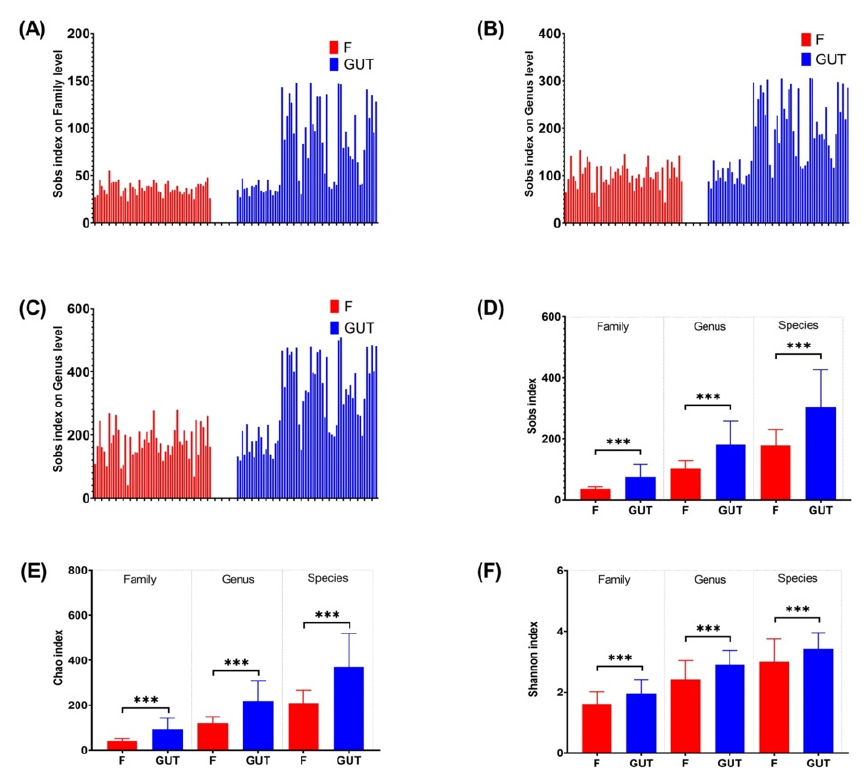
Figure 2. α -diversities of the gut microbiome in MDD and control cases. α -diversities were estimated at the family ( A ), genus ( B ) and species ( C ) levels by the Sobs index. The Wilcoxon rank-sum test was performed to compare Sobs index ( D ), Chao index ( E ) and Shannon index ( F ) values of OTUs at the family, genus and species levels between the MDD (F, red bars) and control (GUT, blue bars) groups. Data are presented as the mean ± standard deviation. *** p < 0.001.